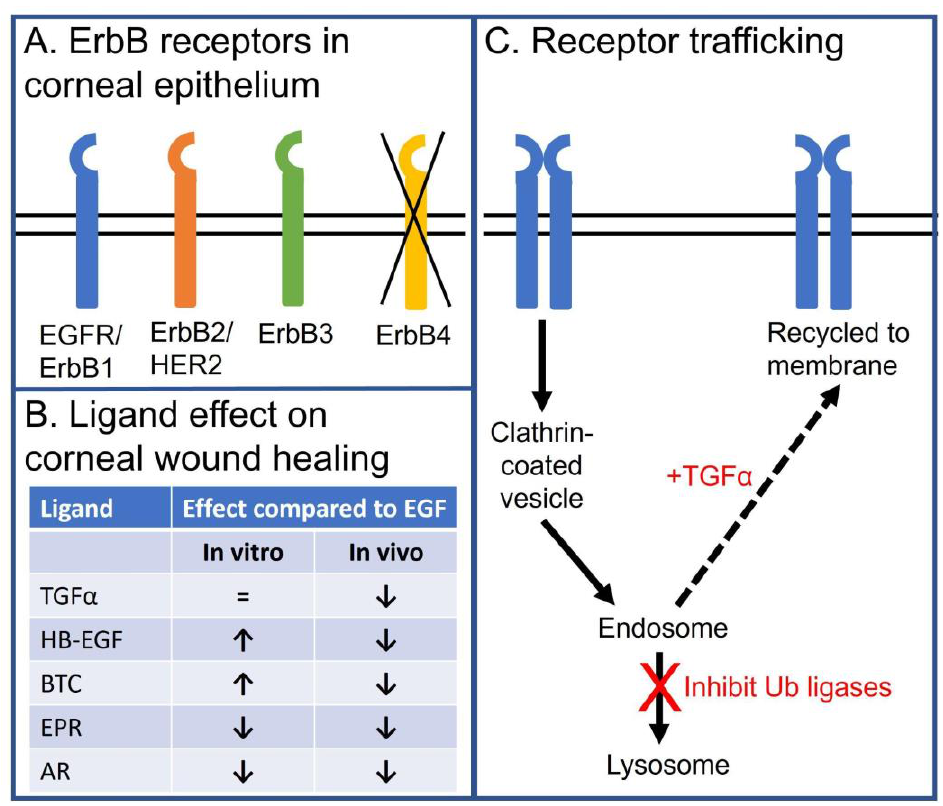
Figure 3. Schema summarizing the role of EGFR and ErbB family members in the corneal epithelium. ( A ) Schematic depicting expression of EGFR (ErbB1), ErbB2 (Her2), and ErbB3, but not ErbB4, in corneal epithelium. ( B ) Table summarizing the effects of endogenous EGFR ligand on in vitro and in vivo corneal epithelial wound healing. ( C ) Schematic depicting how EGFR endocytic trafficking affects receptor signaling in corneal epithelial cells. EGF stimulation promotes internalization of the EGF:EGFR complex to the early endosome. During internalization, the receptor is ubiquitylated and targeted for trafficking to lysosome for degradation. EGFR degradation can be diverted from a degradation pathway by promoting receptor recycling. This can be achieved by stimulating with TGF α , a ligand that dissociates in the mildly acidic environment of the early endosome and has reduced receptor ubiquitylation, or inhibiting the ubiquitin ligases of the EGFR in corneal epithelial cells (i.e., c-Cbl and